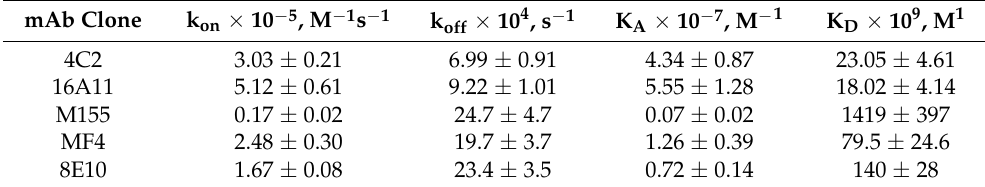
Table 2. Kinetic and equilibrium constants calculated for a variety of clones of mAb to cTnI used as a tracer antibody paired up with 19C7 clone served as a capture antibody. mAb